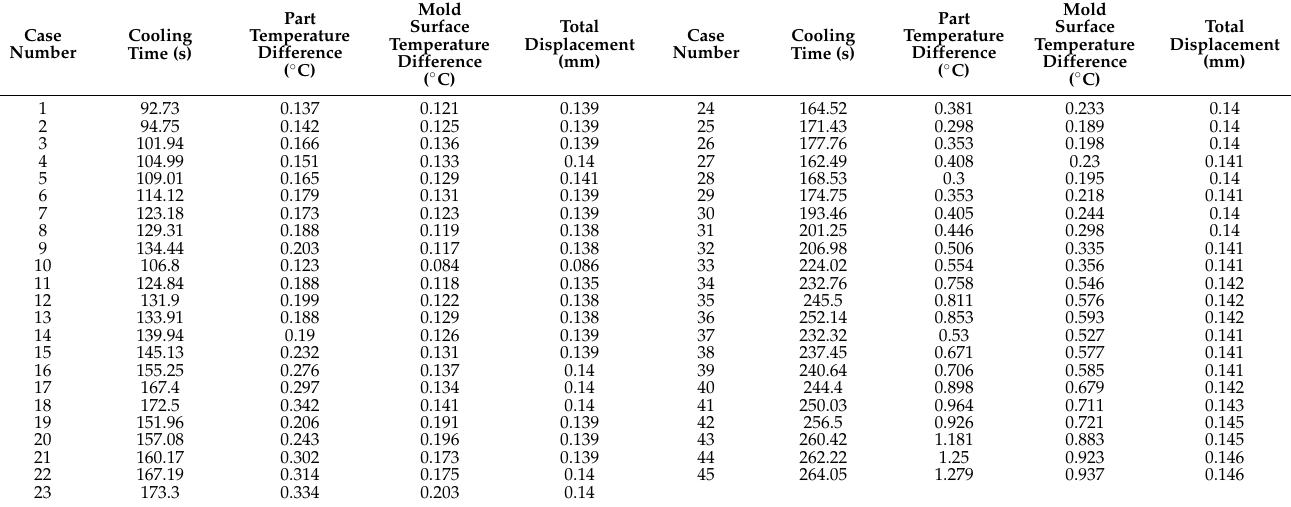
Figure 10. Simulation results of the forty-five cases on the ( a ) cooling time, ( b ) part temperature difference, ( c ) mold surface temperature difference, and ( d ) total displacement. Table 3. Simulation results of the forty-five